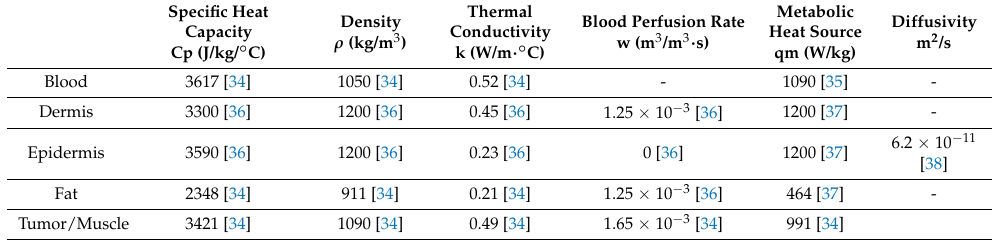
Table 2. Parameters of the meshes for the corresponding geometries of nanoparticles.